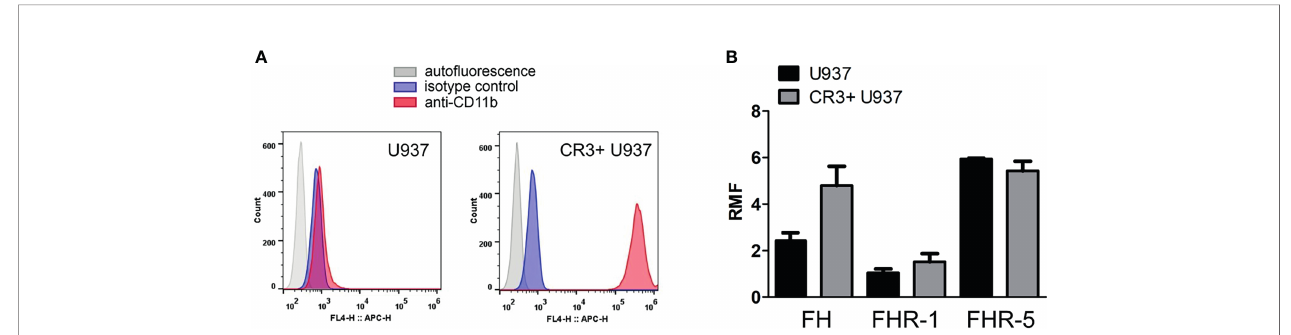
FIGURE 3 | Binding of FH, FHR-1 and FHR-5 to U937 and CR3+ U937 cells. (A) The expression of CR3 on U937 human monocytic cells and U937 cells overexpressing CR3 (CR3+ U937) was analyzed by fl ow cytometry using an anti-CD11b antibody. Representative histograms are shown. (B) Binding of puri fi ed FH (50 µg/ml) and recombinant FHR-1 (50 µg/ml) and FHR-5 (10 µg/ml) to U937 cells and CR3+ U937 cells was measured by fl ow cytometry. RMF, relative mean fl uorescence. Data are means + SEM from three independent